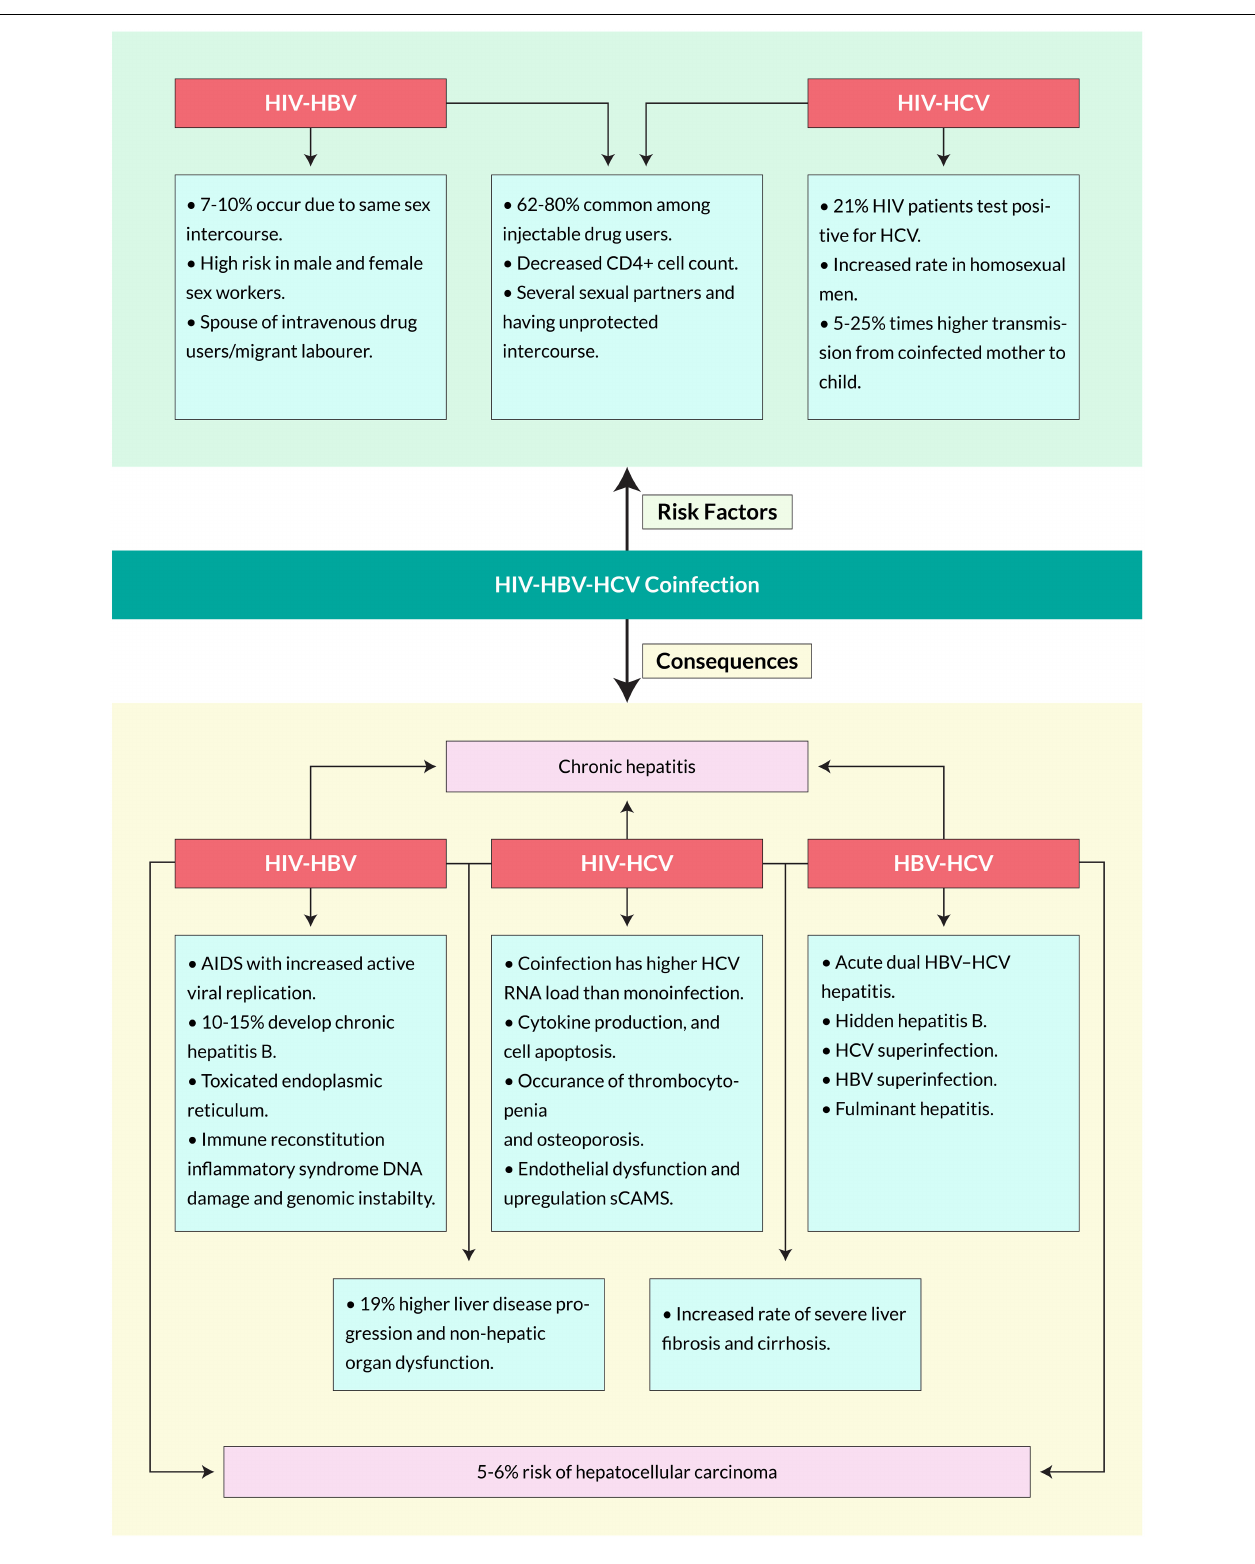
FIGURE 4 | Major risk factors and consequences of HIV, HBV, and HCV coinfection.